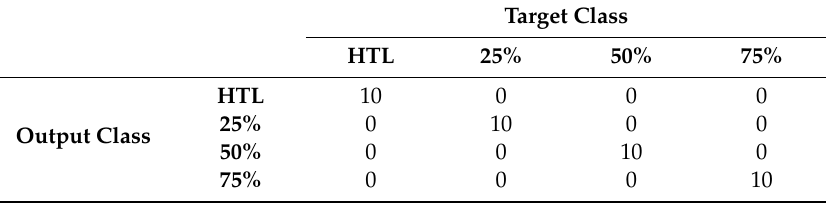
Table 4. Confusion matrix for the validation of the ANN classifier with infrared imaging.